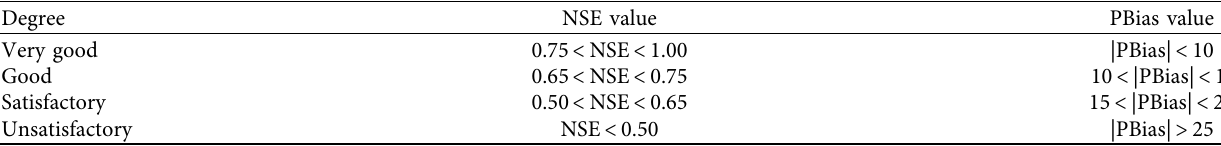
Table 2: NSE and PBias evaluation [31].